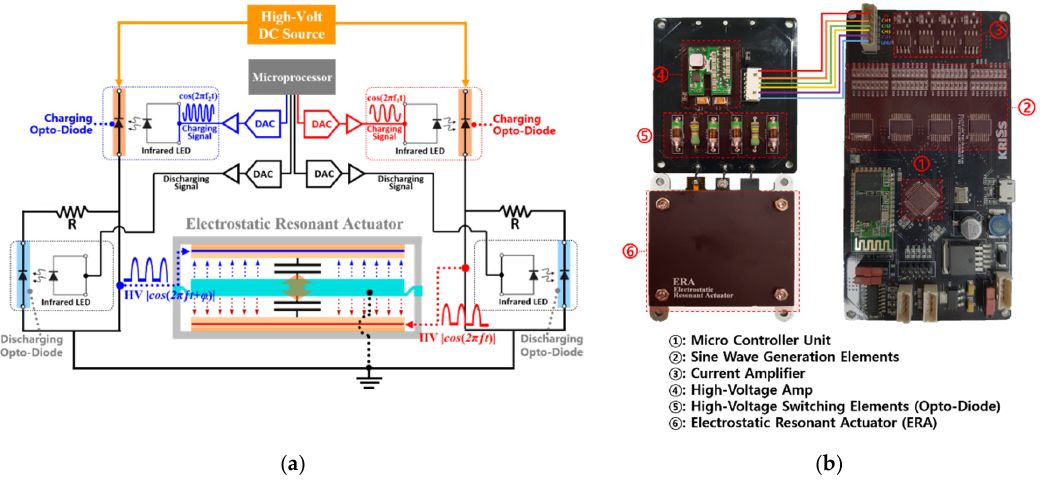
Figure 4. ( a ) Schematic of a circuit diagram for the controller and high voltage amplifier; ( b ) fabricated controller and high voltage amplifier.